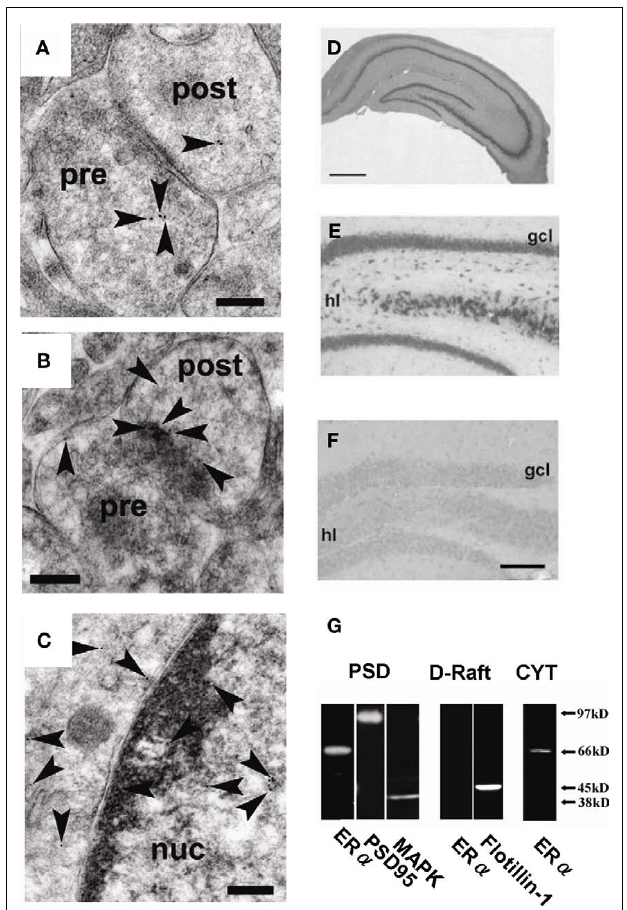
FIGURE 10 | Localization of ER α in hippocampal synapses. (A) – (C) Immunoelectron microscopic analysis of the distribution of ER α within axospinous synapses in the stratum radiatum of the hippocampal slices from adult male rat. (A) Gold particles (arrowheads) were localized in the pre- and postsynaptic regions. (B) In dendritic spines, gold particles were associated with PSD regions. (C) Gold particles were also localized in the nuclei. Pre, presynaptic region; post, postsynaptic region; Scale bar, 200nm. (D–F) Immunohistochemical staining of ER α in the hippocampal slices from adult male rat [ (D) : whole hippocampus; (E) : DG] and adult male ER α KO mouse [ (F) : DG]. gcl, Granule cell layer; hl, hilus. Scale bar, 500 μ m for (D) , and 200 μ m for (E,F) . (G) Western blot analysis of ER α in male rat hippocampal neurons. Blot of ER α in postsynaptic density (PSD), dendritic raft (D-Raft), and cytoplasm (CYT). From left to middle, blot of PSD fractions with RC-19 IgG (ER α ), PSD-95 IgG (PSD-95), and Erk MAP kinase IgG (MAPK). From middle to right, blot of D-Raft with RC-19 (ER α ) and flotillin-1 IgG (flotillin-1). At right-most lane, blot of CYT with RC-19 (ER α ).The amount of protein applied was 20 μ g for each lane, except for left-most PSD lane in which 60 μ g protein was applied in order to improve the signal to noise ratio. Modified from Mukai et al. (2007, 2010).